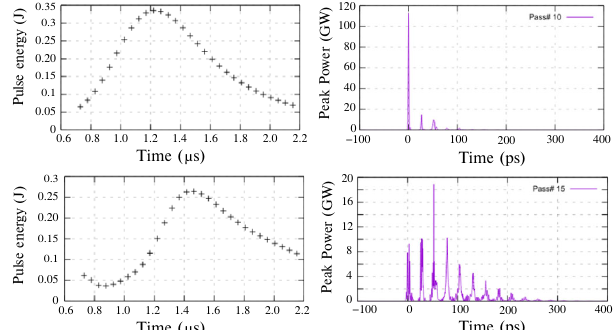
FIG. 7. Pulse train build up in ideal cavity with isotopic gain broadening (top) and in actual cavity with nonlinear effects in windows included (bottom). The zero of the time-axis corre- sponds to the trigger of the pumping discharge in the amplifier. The injection time for the first pass corresponds to 0 . 7 μ s on this scale. The temporal profiles of the corresponding pulses at the peak of the pulse train are also shown. structure from the roto-vibrational lines of CO 2 molecules.